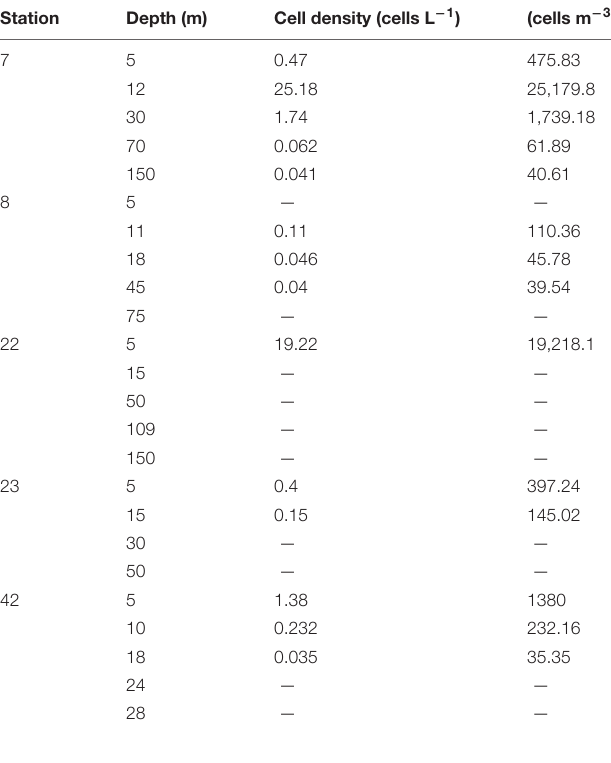
Stations, depths, and abundances (both in cells L − 1 and cells m − 3 ) are